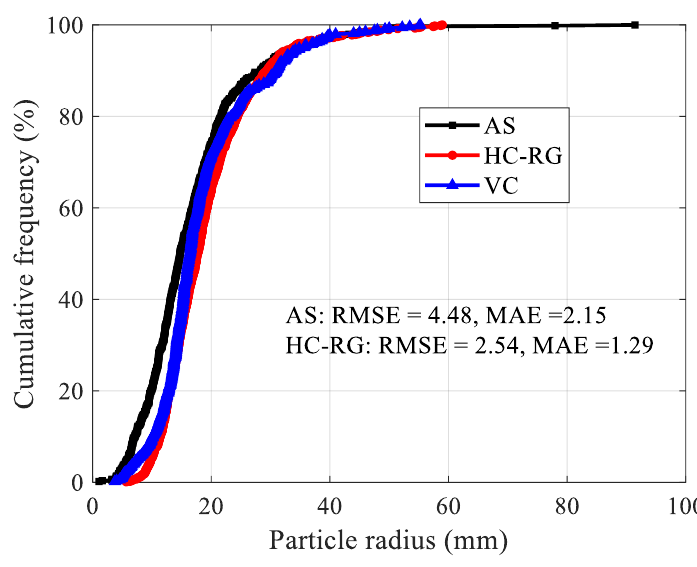
Figure 12. Comparison of recognition performance of mixed material loose accumulation: ( a ) point cloud, ( b ) separation processing, ( c ) peak points of each block region, ( d ) recognition using HC-RG algorithm, and ( e ) recognition using AS algorithm.